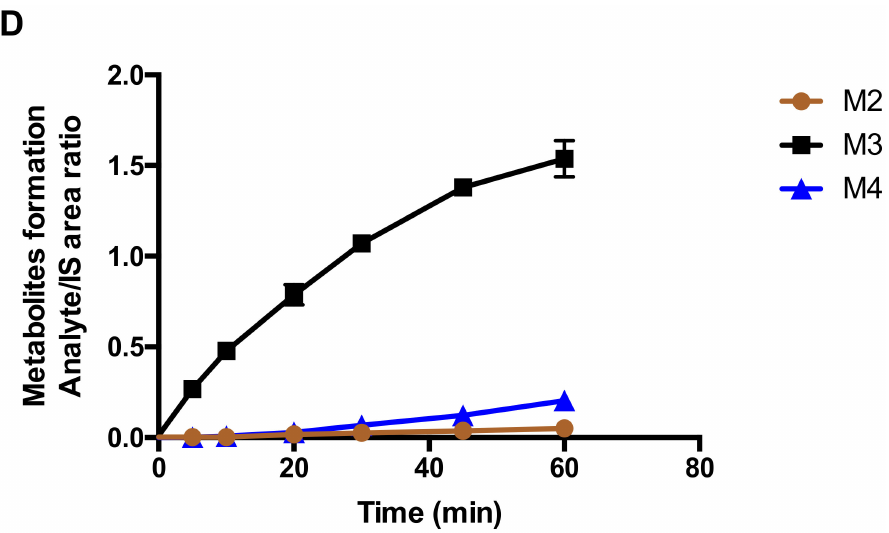
Figure 3. Detection of Compound- 3 metabolites in vitro. ( A ) Representative ion chromatogram in HLM; ( B ) Representative ion chromatogram in RLM; ( C ) Metabolite formation in HLM; ( D ), Metabolite formation in RLM. Metabolic profiles of HLM and RLM samples were collected after 60 min incubation of Compound- 3 (10 µ M), liver microsomes (1 mg/mL) and NADPH at 37 ◦ C (n = 3). For